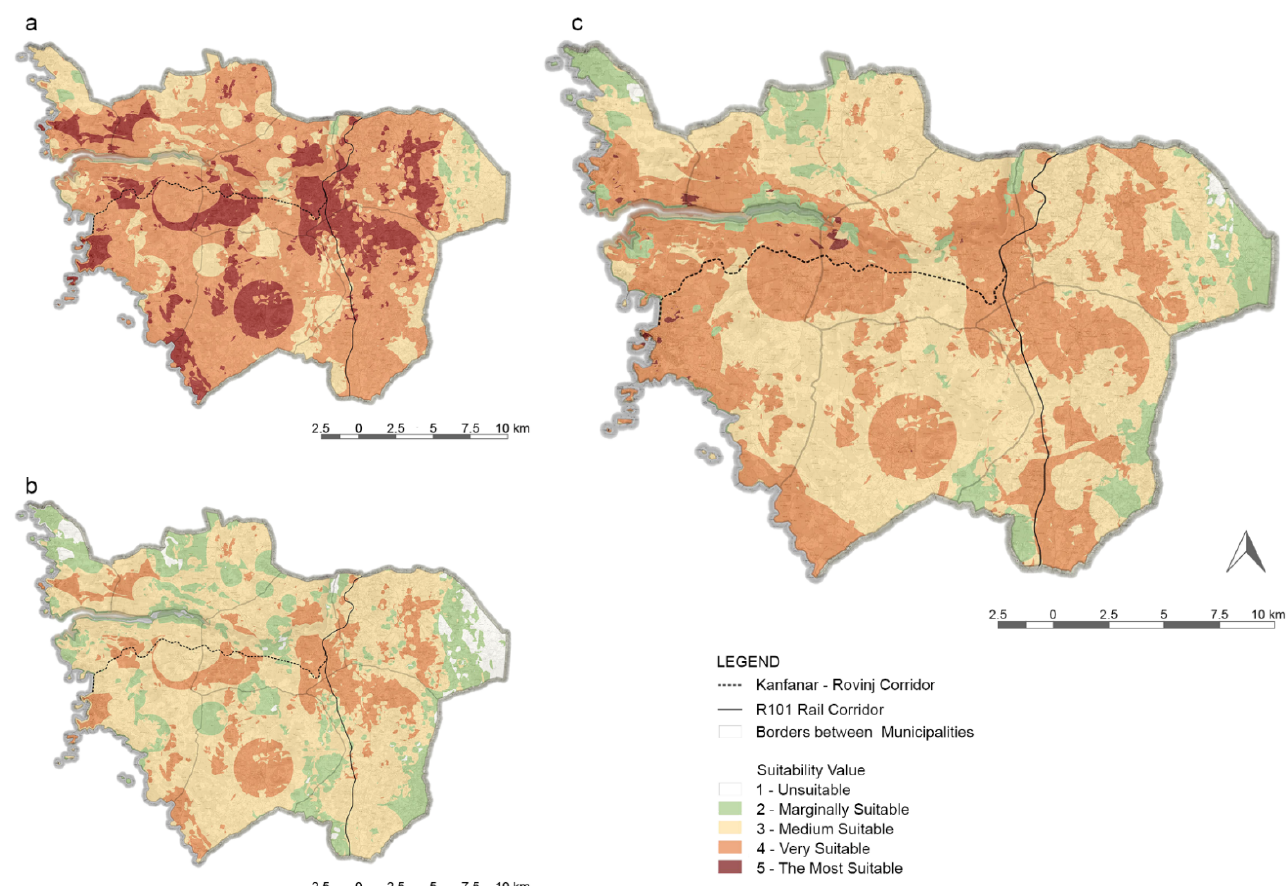
Figure 6. ( a ) Development aspect of the suitability model; ( b ) Protective aspect of the suitability model; ( c ) Compromise aspect of the suitability model.